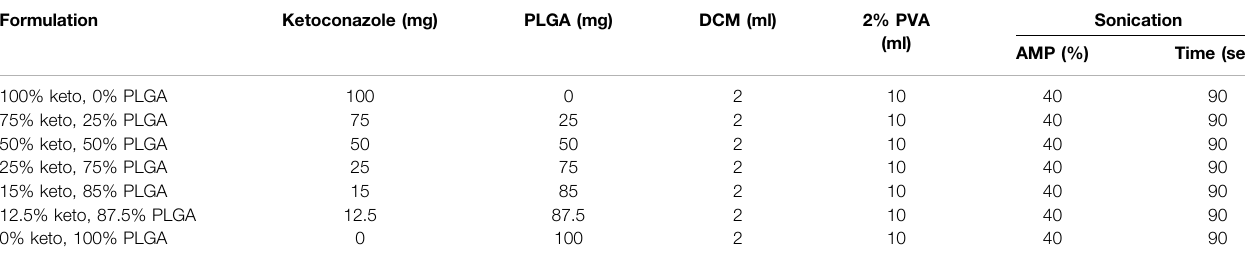
TABLE 1 | Various formulations of ketoconazole-loaded PLGA nanoparticles. Formulation Ketoconazole